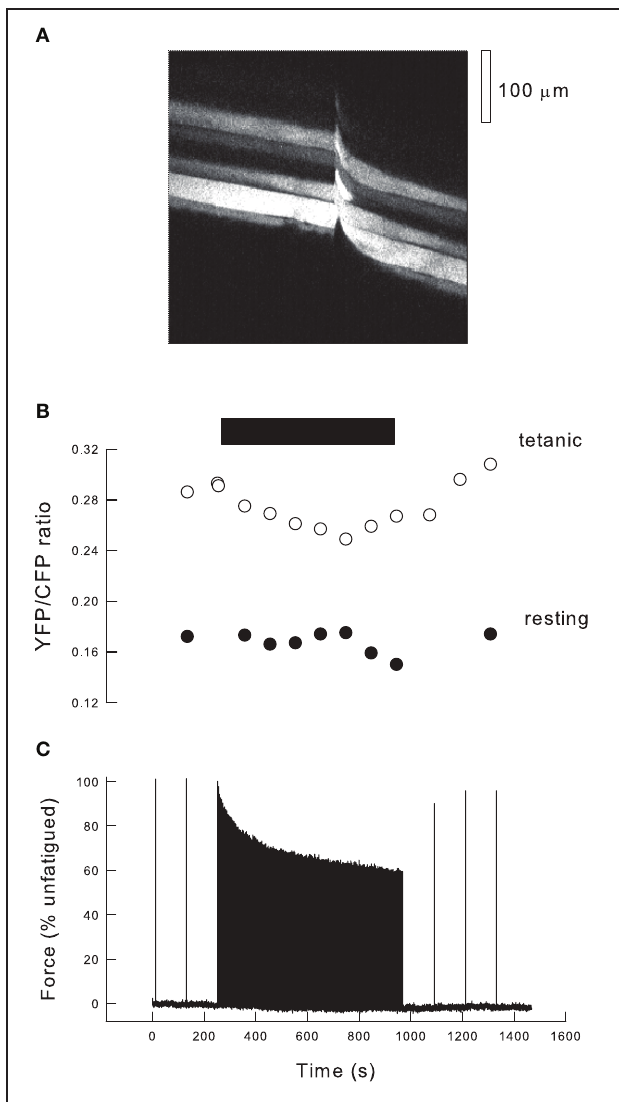
FIGURE 3 | Fatigue in the exteriorized mouse tibialis anterior muscle. (A) Fluorescence image of tibialis anterior muscle 10 days after transfection with cameleon (YC2). Image was scanned from L to R over 750ms, and the muscle stimulated after 400ms (indicated by movement artifact). Thus, in the L part of the image the fibers are resting whereas in the R part of the image the fibers are tetanized. (B) Records of the ratio of fluorescence of YFP/CFP obtained from images such as (A) during a fatigue protocol. Black bar indicates period of high duty cycle stimulation. Empty circles indicate ratios determined during tetani (R hand images in Panel A ), filled circles show ratios from the resting muscle just prior to tetani (L hand images in Panel A ). (C) Record of force during the stimulation protocol. Initially the muscle is stimulated every 2min and force is stable. When duty cycle is increased to one tetanus every 4s, force declines exponentially and approaches a steady state. Stimuli are then given every 2min and force recovers to ∼ 90% of the initial